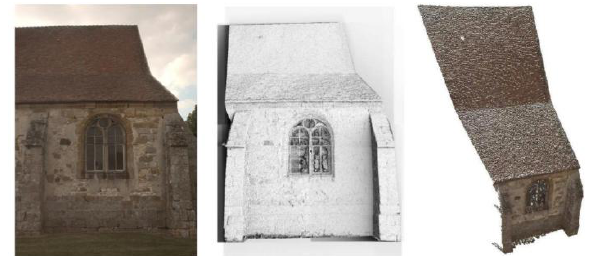
Figure 2: The multi-stereo image matching method: the master image (left), the matching result in the last pyramidal step (center) and the generated colorized point cloud (right) The dense point cloud of the building could be created directly by superposing each point cloud associated to each master image, as the orientation and the position of each image are considered at the moment of the generation of point clouds (Figure